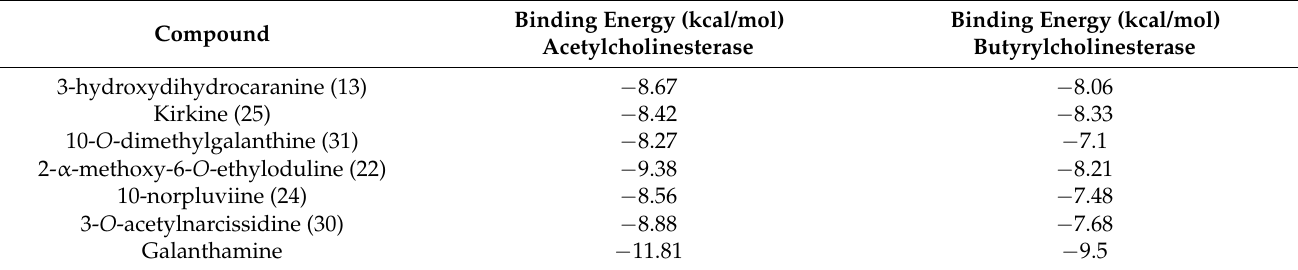
Table 3. Binding energies obtained from docking experiments of selected major alkaloids in Phycella cyrtanthoides bulbs and leaves extracts, as well as the known inhibitor galanthamine